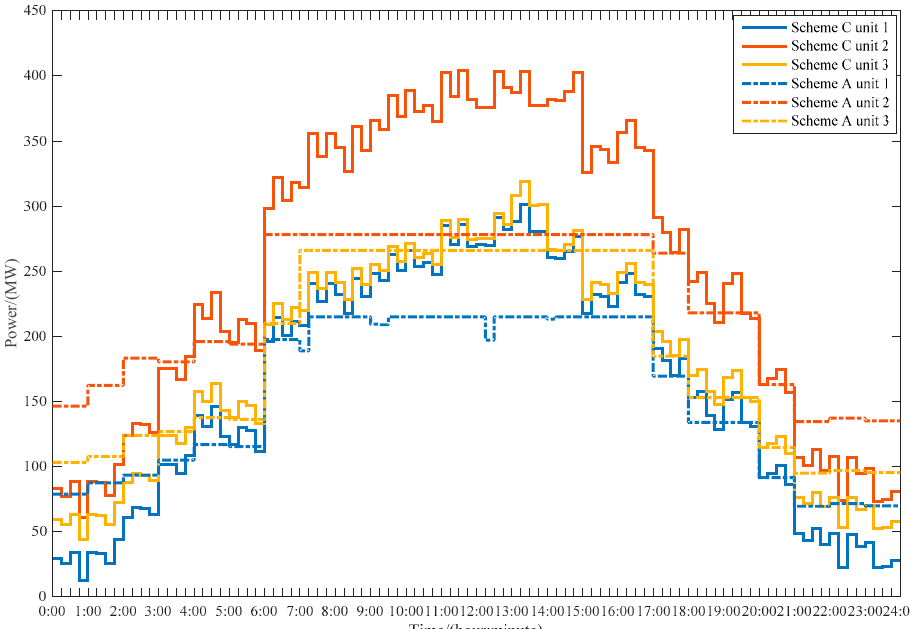
Figure 10. Thermal generator power outputs after applying the hour-level rolling correction scheduling of schemes A and C.